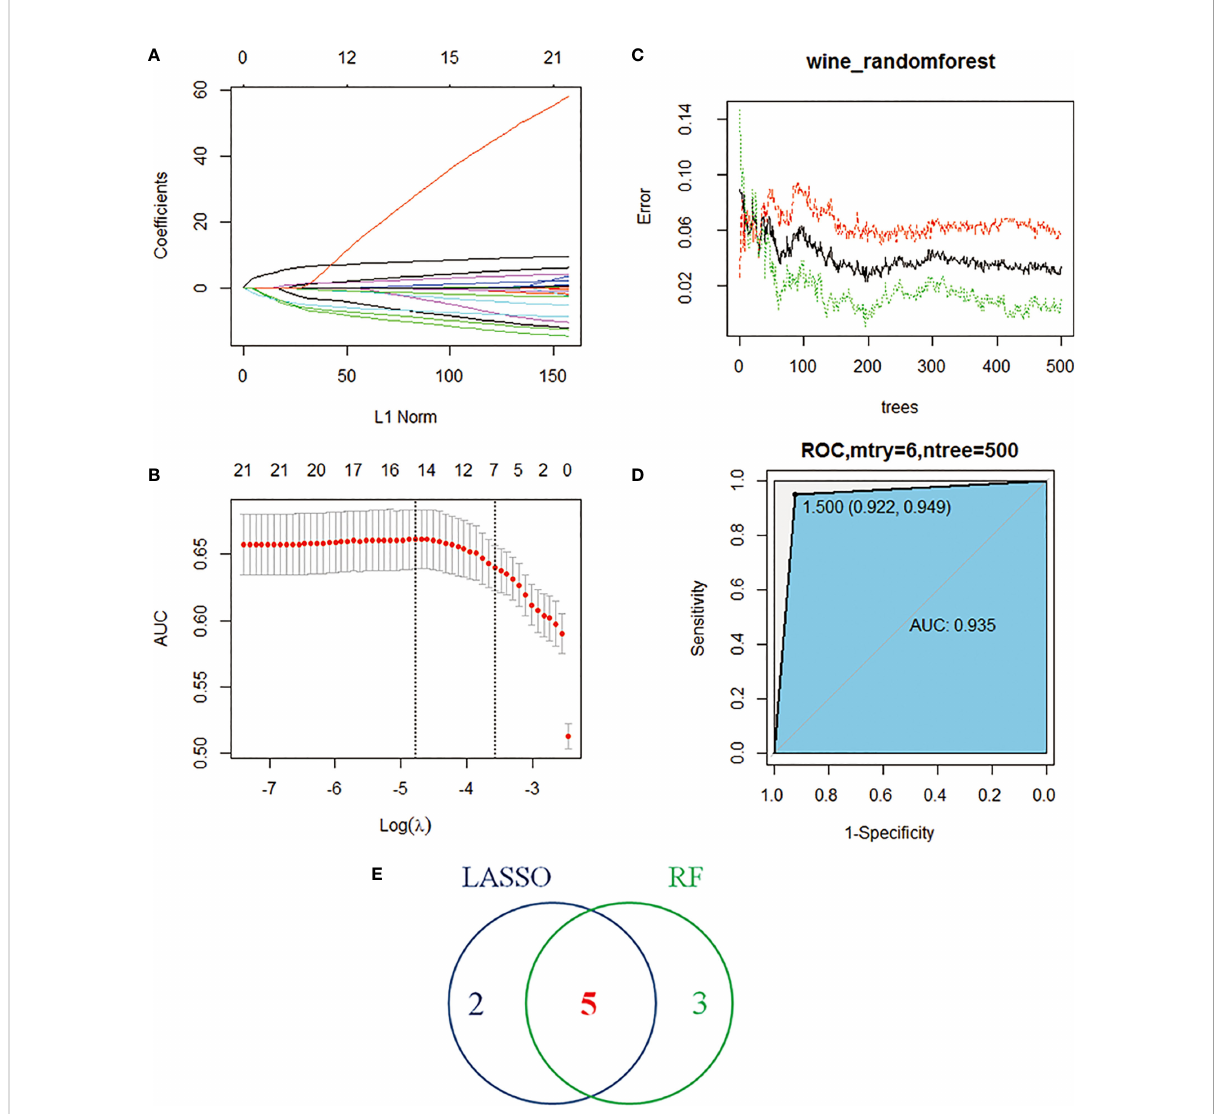
FIGURE 4 Machine learning identi fi es key immune cells. (A) Distribution of LASSO coef fi cients for 22 immune cells. (B) Penalty plot of 22 immune cells in the LASSO model, error bars represent standard error. (C) the error variation of the RF algorithm, red and green represent the error rate of high and low FAM83A expression groups, and black represents the over fl ow error rate. (D) Random forest analysis results (E) . Five immune cell types identi fi ed by LASSO and RF